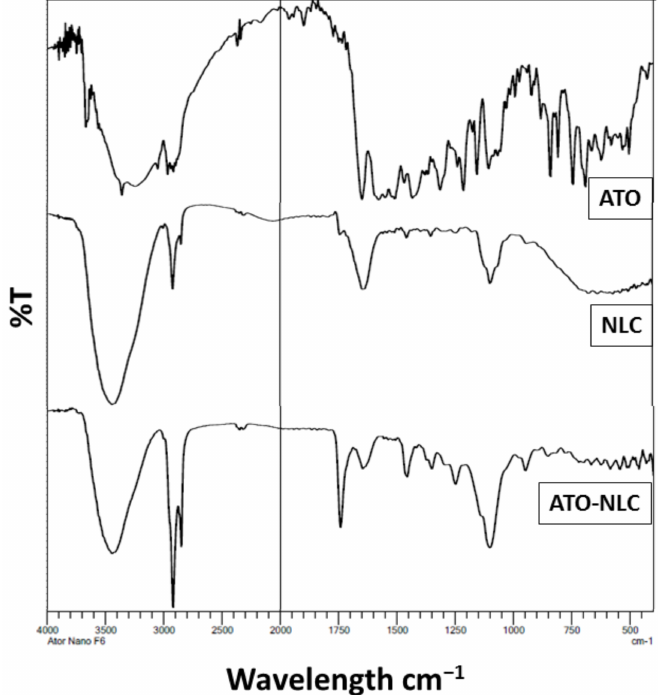
Figure 7. FTIR spectra of pure ATO, free NLC and optimized ATO-NLC formulation.